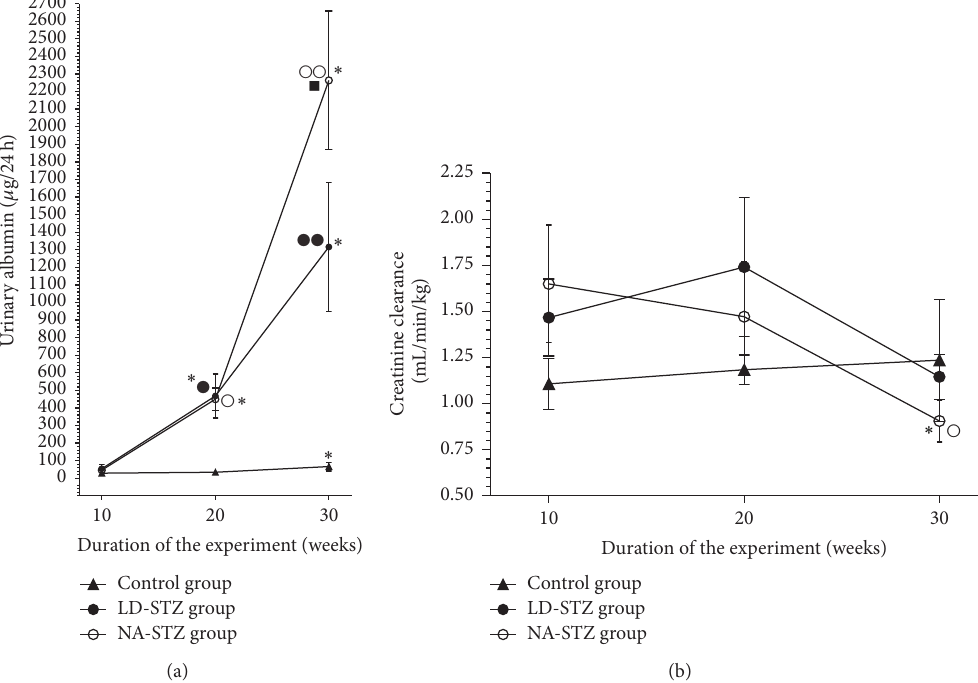
Figure 6: Routine renal function markers in the control, NA-STZ, and LD-STZ groups during the experiment. (a) Dynamics of urinary albumin excretion ( 𝜇 g/24h) measured at weeks 10, 20, and 30 of the experiment in the studied groups. (b) Dynamics of calculated clearance of creatinine (mL/min/kg) measured at weeks 10, 20, and 30 of the experiment in the studied groups. Mean values and standard deviations are shown. I – 𝑃 < 0.05 , II – 𝑃 < 0.005 in NA-STZ diabetic group versus control nondiabetic group at the same point of measurement. e – 𝑃 < 0.05 , ee – 𝑃 < 0.01 in LD-STZ diabetic group versus control nondiabetic group at the same point of measurement. ◼ - 𝑃 < 0.05 in NA-STZ group versus LD-STZ group at the same point of measurement. ∗ 𝑃 < 0.05 compared to the first measurement in the same group at week